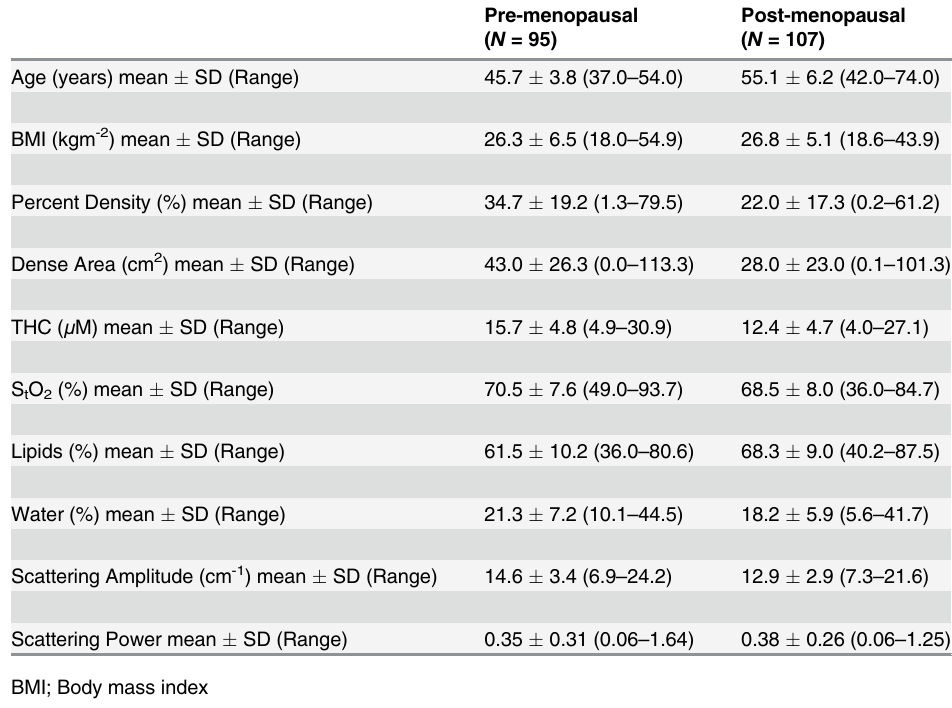
Table 2. Means and standard deviations (SDs) of percent mammographic density, dense area, age, BMI and OS tissue optical properties by menopausal